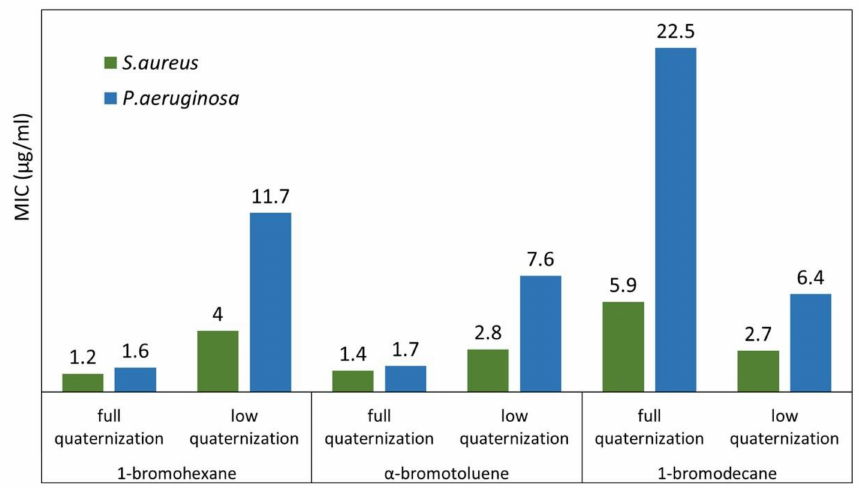
Figure 11. MIC ( µ g / mL) values measured for linear QA-PEI, distinguished by their quaternization degree and N -alkyl substituents, in tests against S. aureus and P. aeruginosa . Data from